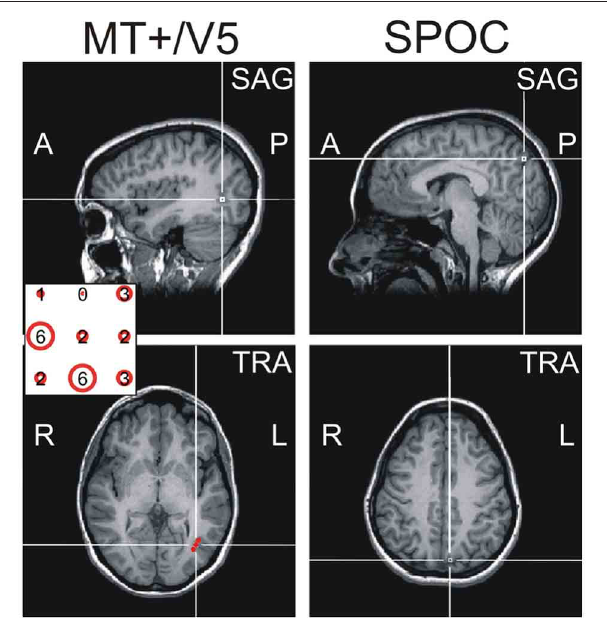
FIGURE 1 | Exemplary sagittal (SAG, top) and transversal (TRA, bottom) views of the MRI of one participant, illustrating the functional location of MT + /V5 (left) and the anatomical location of SPOC (right) using cross-hairs. The inset for the MT + /V5 images illustrates, for all nine grid points (whose top view is illustrated in sagittal view), the difference between trials with and trials without TMS in direction judgments during the functional localizer. As can be seen, the largest effect for this participant was found for the left-center and middle-bottom points. For the left-center point, however, this effect was mainly caused by deviating performance in the trials without TMS; for this reason, we identified the middle-bottom point as the functional MT + /V5 for this participant. For most participants, a single point could be identified where the TMS effect was